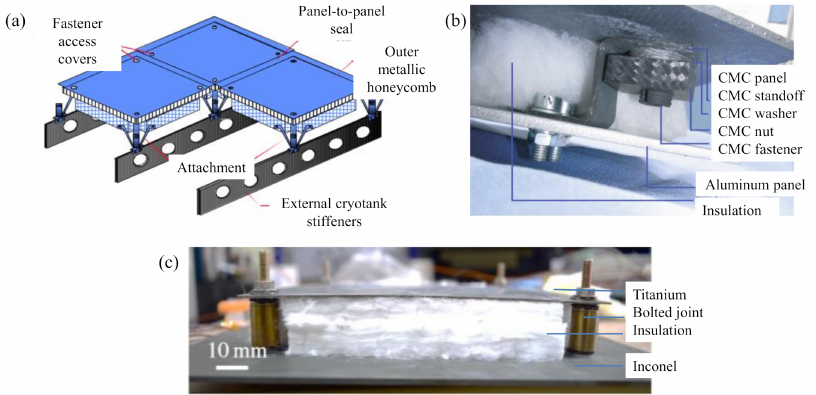
Figure 1. Use of fasteners in thermal protection system (TPS) panels: ( a ) metallic TPS panel designed for the X-33 spaceplane [18], ( b ) ceramic-metallic TPS panel designed for the SHEFEX II [19], and ( c ) metallic TPS panel designed for the current